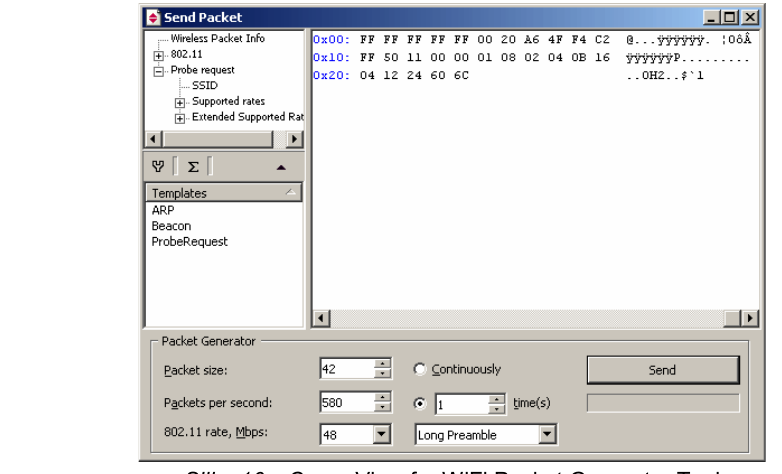
Figure 16 – CommView for WiFi Packet Generator